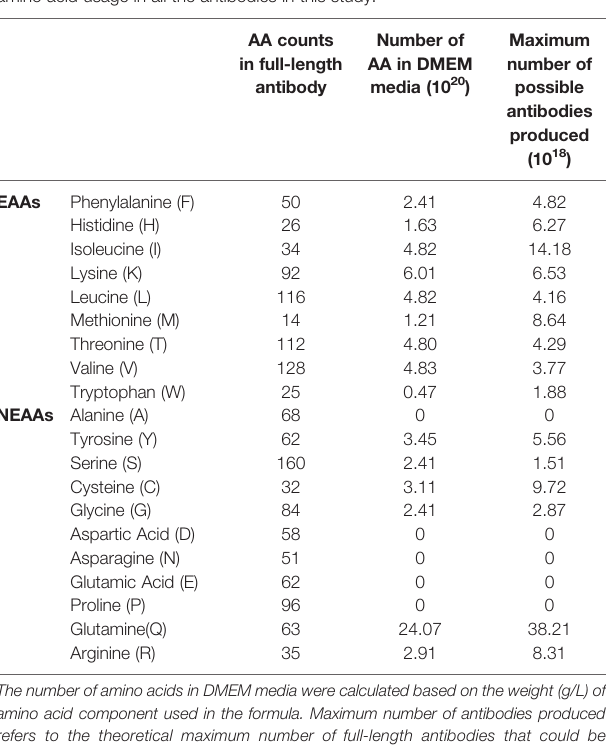
TABLE 2 | Amino acid counts in DMEM media and the representative average of amino acid usage in all the antibodies in this study. AA counts in full-length antibody